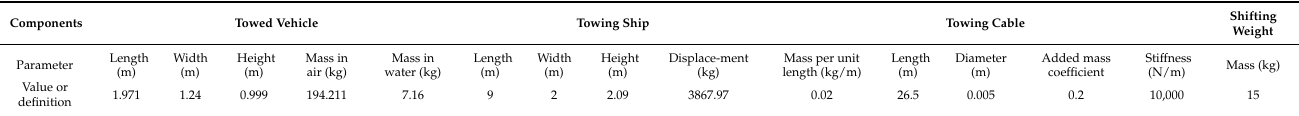
Table 1. Primary parameters of the underwater towed system.